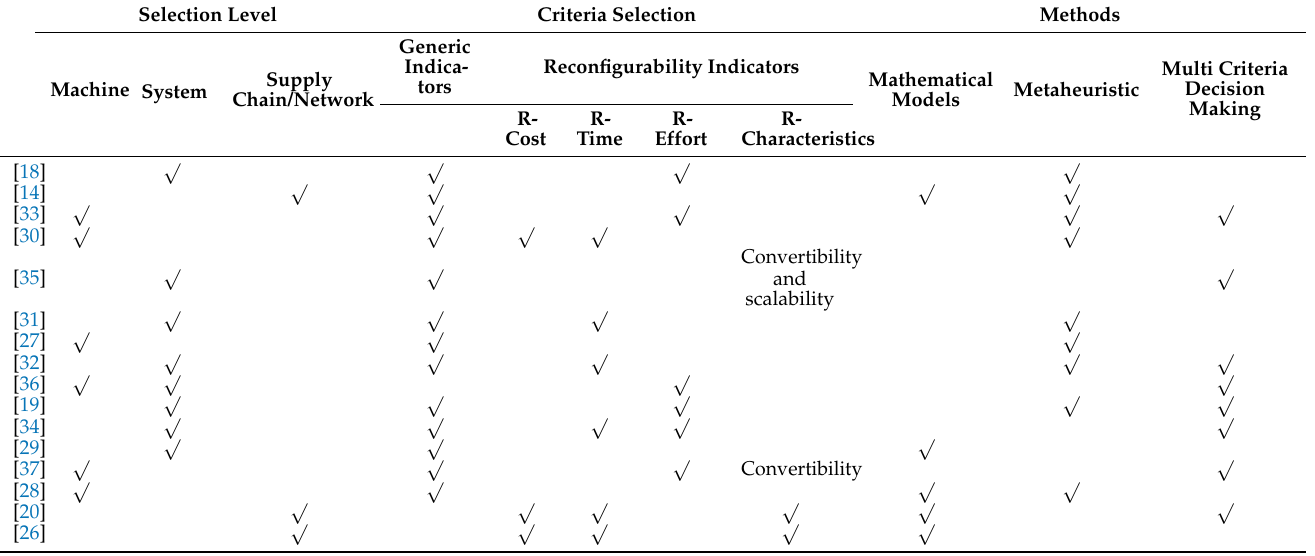
Table 2. Classification of configurations selection approaches proposed in the context of